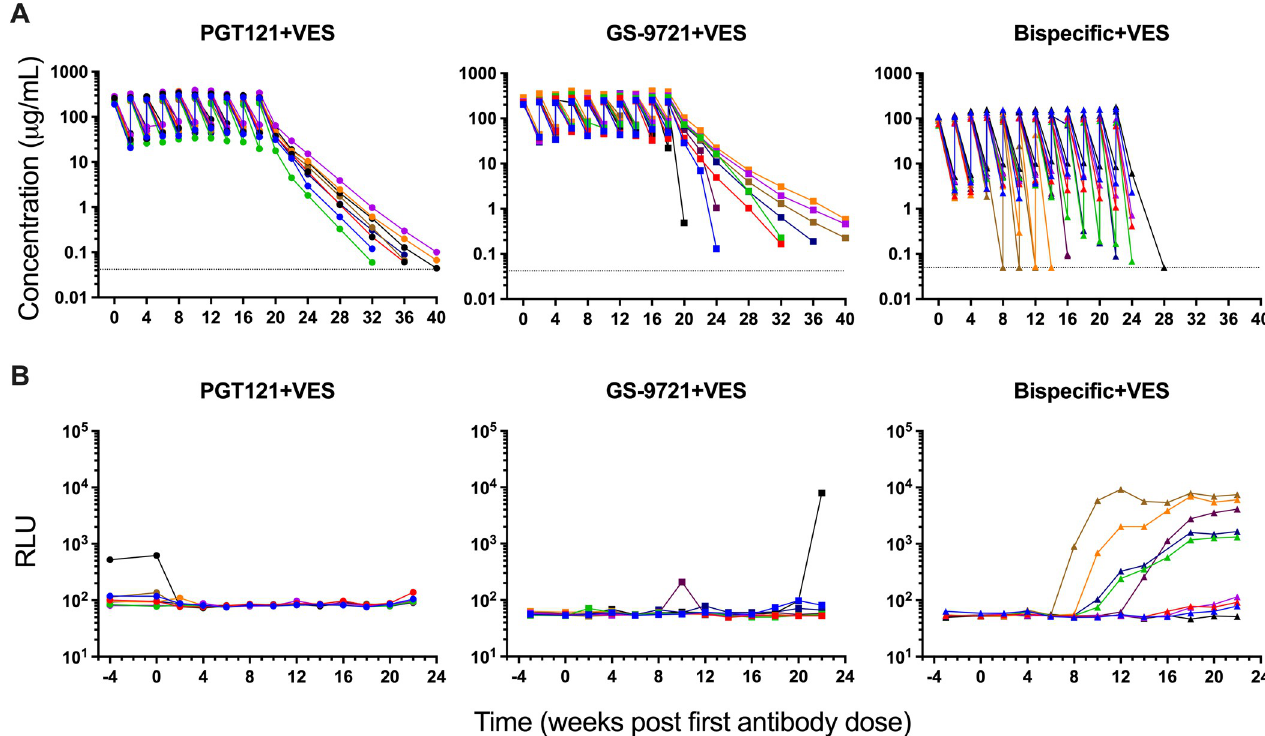
Fig 2. Antibody pharmacokinetics and anti-drug antibody (ADA) in serum before ART discontinuation. (A) Peak serum antibody levels are shown following each of the ten infusions of antibody and during the washout period. Dotted lines indicate limit of detection, values on the line were below limit of detection. (B) ADA responses were assessed at week -4 and every 2 weeks from week 0 to week 22. Individual symbol and color coding as indicated in S1 Table.